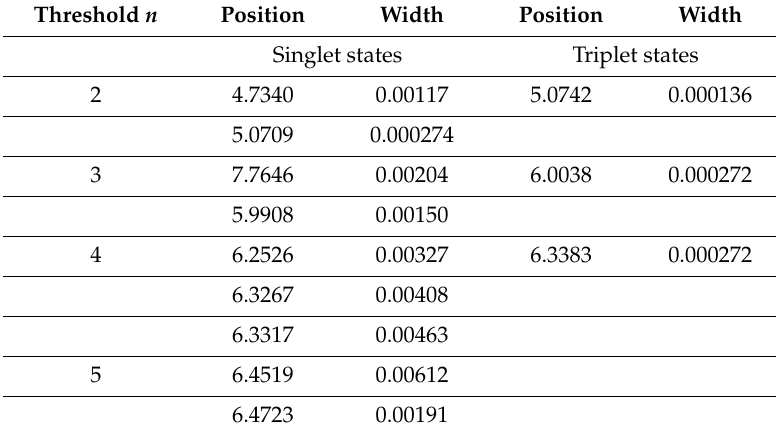
Table 18. Resonance positions (eV) are relative to the ground state of Ps −